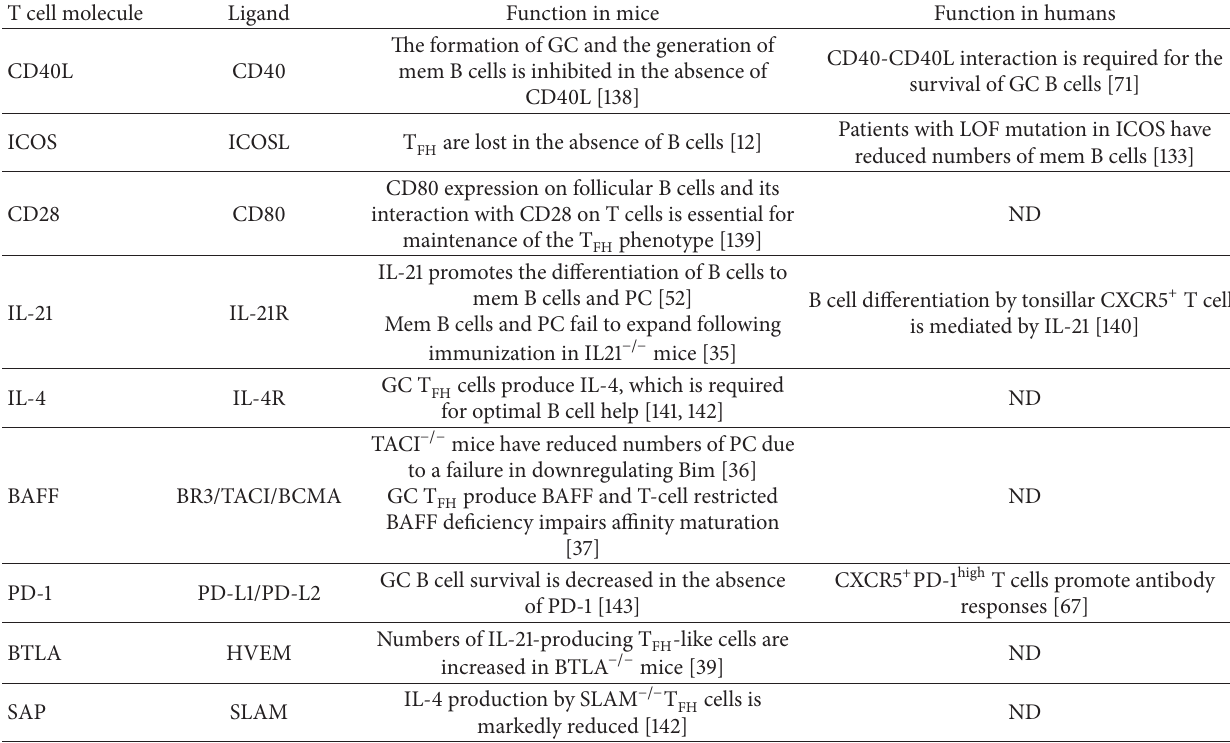
-related molecules during B cell help, T FH